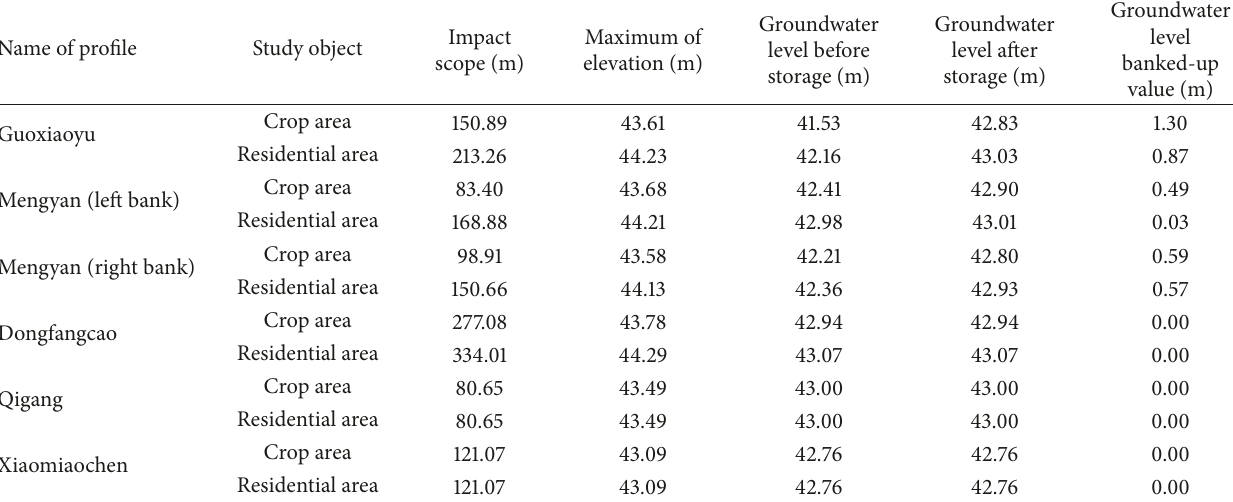
Table 4: Immersion zone and corresponding maximum elevation after reservoir